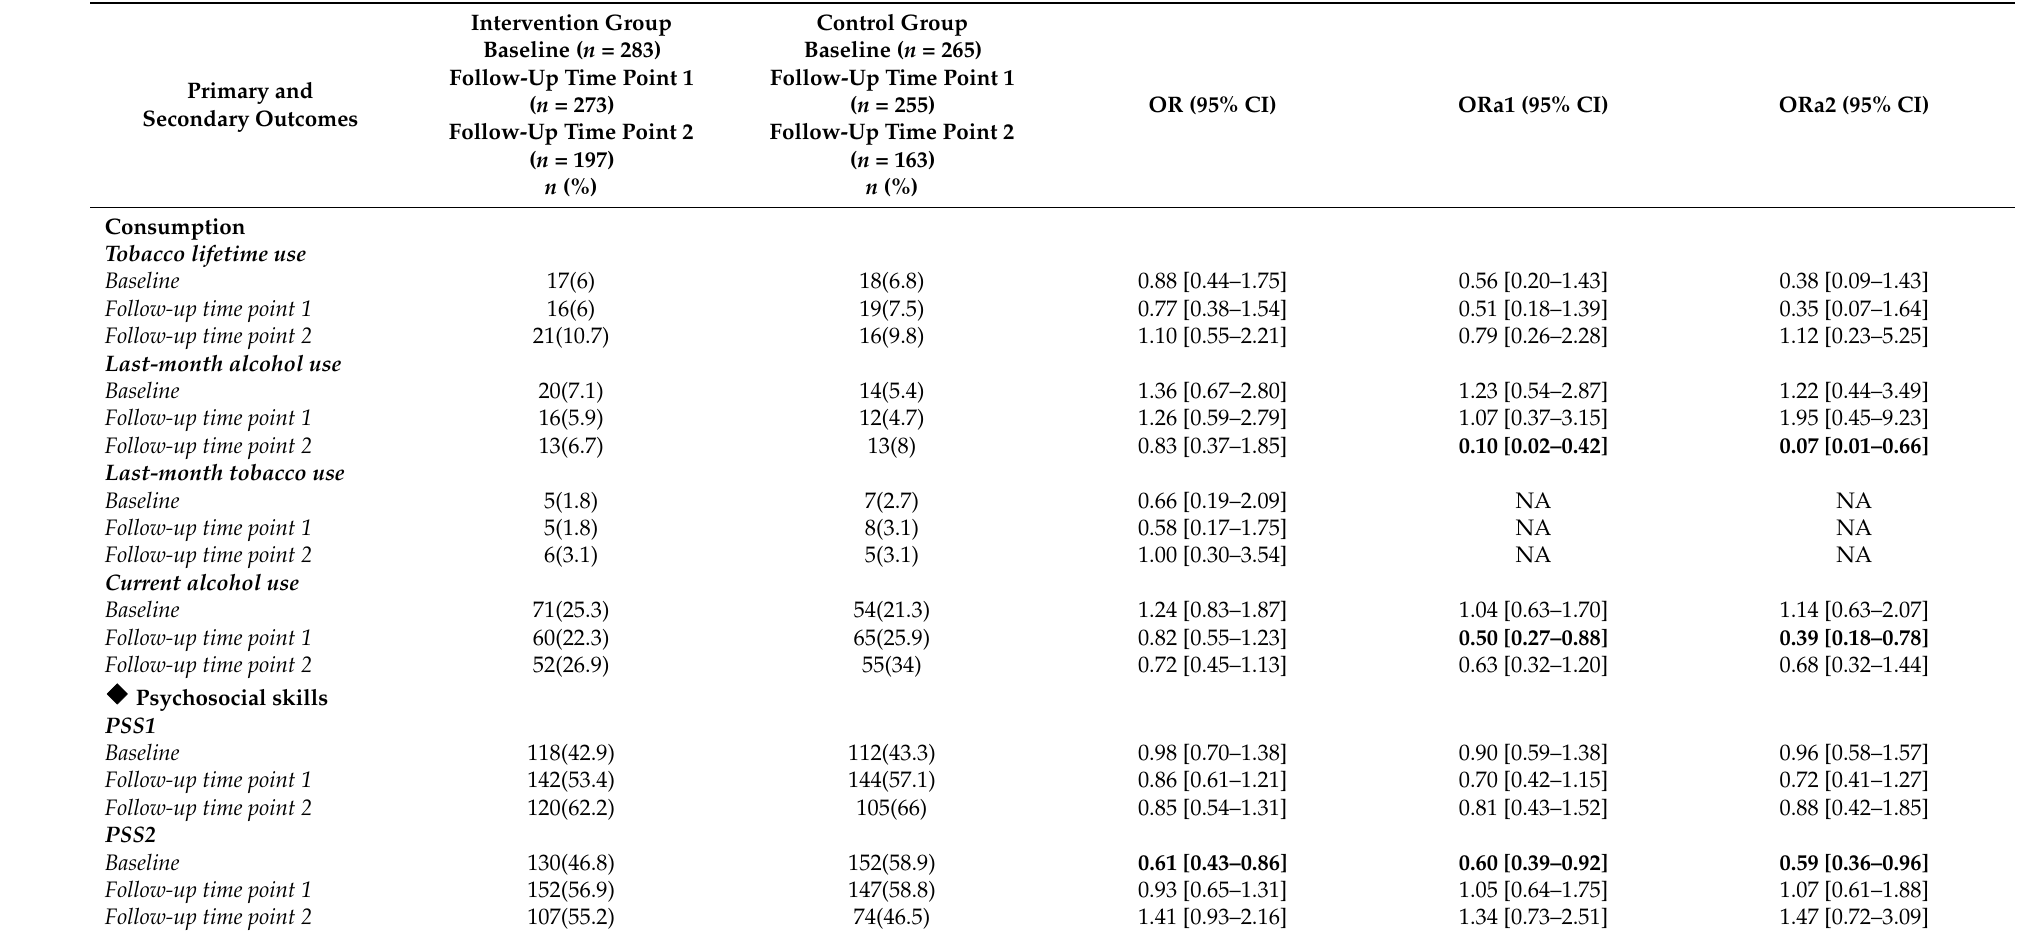
Table 1. Results of the bivariate and multivariate logistic regression analysis at baseline and across follow-up time points 1 and 2.